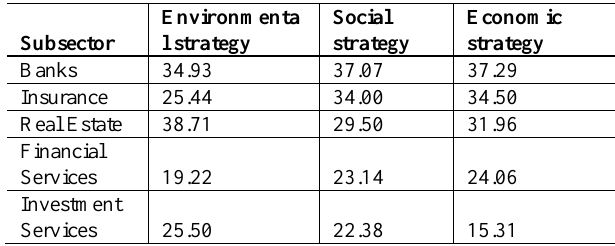
Table 4A: Mean ranking